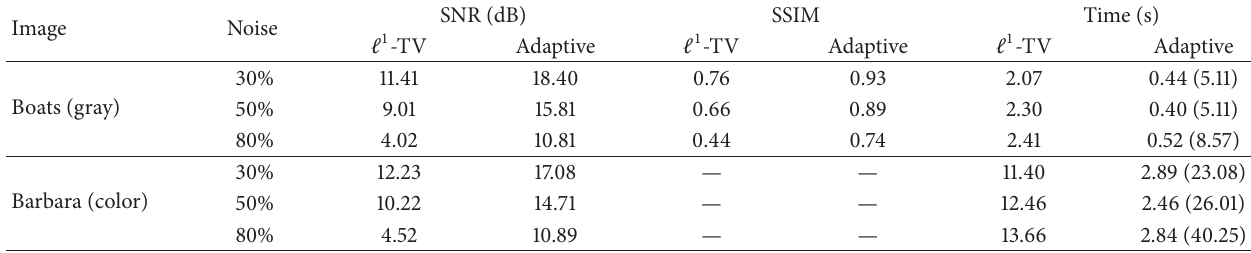
Table 2: Denoising performance results for the ℓ 1 -TV and the adaptive ℓ 1 -TV methods for the grayscale “Boats” ( 512 × 512 ) image and the color “Barbara” ( 720 × 576 ) image. Time in parenthesis (adaptive case) corresponds to time elapsed to estimate the pixels corrupted with Salt & Pepper